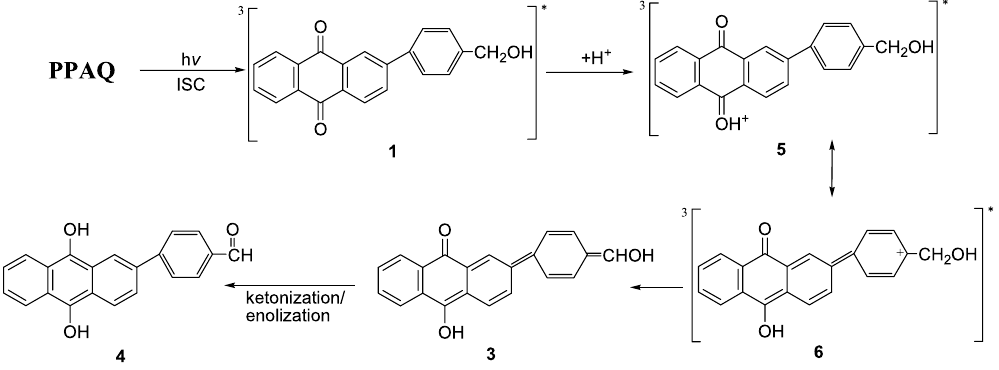
Figure 3. A proposed two-step reaction mechanism of the photoredox reaction of PPAQ in acidic aqueous solutions based on the results of a previously reported mechanism study on HEAQ is shown.